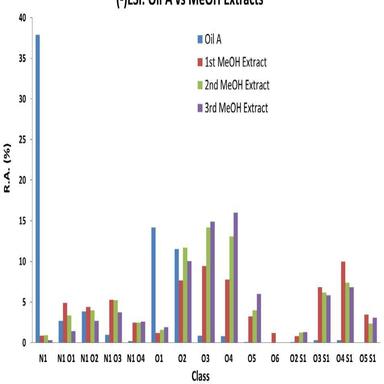
Class distribution of oil A, the 1st, 2nd and 3rd methanol extracts in (−)ESI.